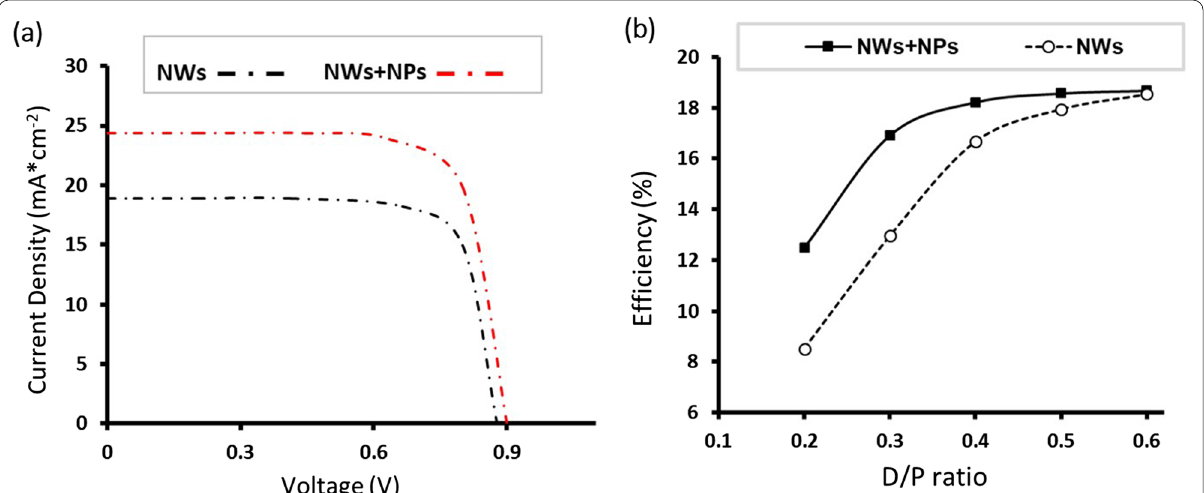
Fig. 9 a Comparison of I – V characteristics between bare NWs and NWs with 60-nm Au NPs; b photoconversion efficiency of NWs with different D / P decorated with 60-nm Au